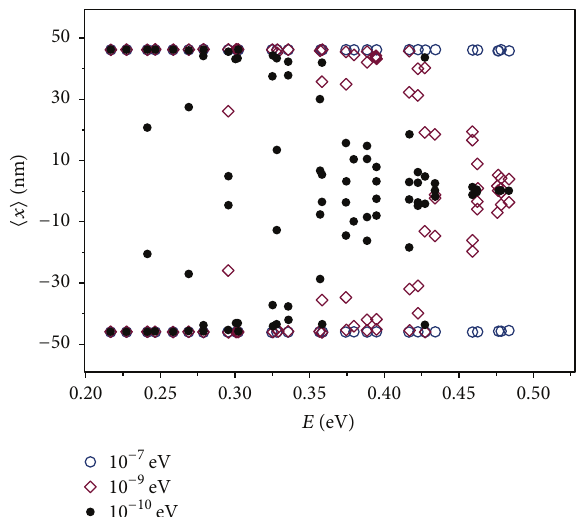
Figure 4: Spectral distributions for the average coordinate ⟨𝑥⟩ for a circular DQW. The symbols correspond to discretization of the Schr¨odinger equation on various numerical meshes. The meshes differ by the elements minimum size. The energy splitting ( Δ𝐸 ) of thequasidoubletofthegroundstateforeachdiscretizationofamesh is given in the inset. The finer mesh corresponds to smaller Δ𝐸 . Interdot distance 𝑎 is kept the same and equal to 26 nm.